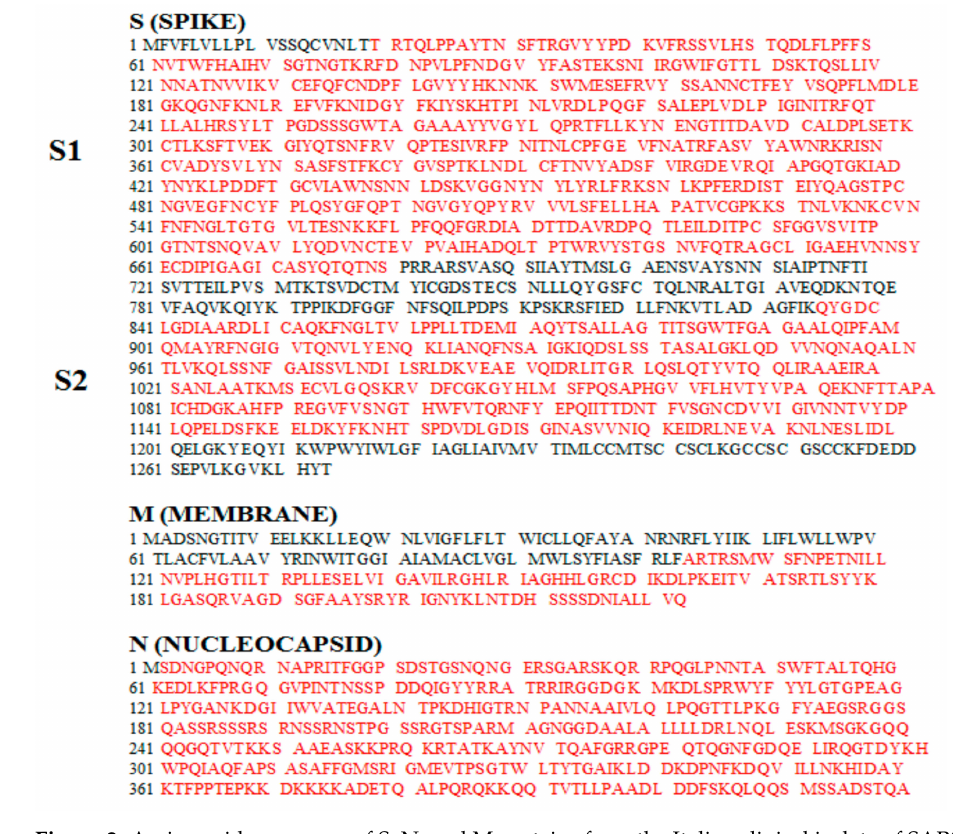
Figure 2. Amino acid sequences of S, N, and M proteins from the Italian clinical isolate of